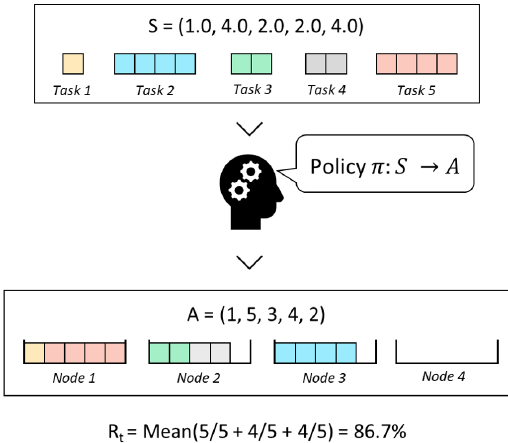
Figure 6. Input–output representation example for a set of five tasks and node capacity C = 5, for the case where the NF allocation heuristic is followed. The set of available tasks is a sequence containing the cost of each task. Concerning the output of the DNN, the sequence A is the order in which the tasks are allocated following the NF rule. This is a simple example, but maximizing the occupancy ratio is an NP-optimization problem, which becomes challenging to solve for large sets of